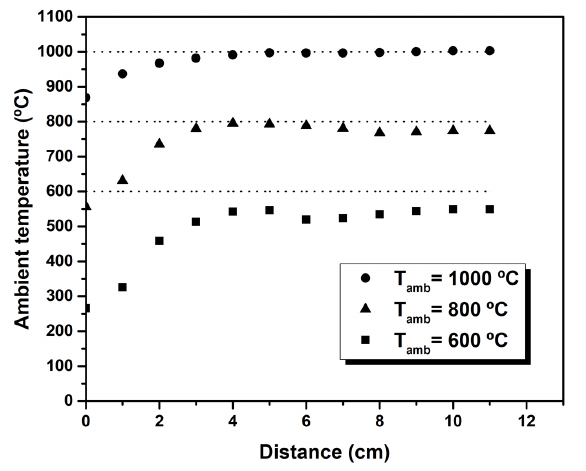
Figure 7. Temperature profile along the quartz